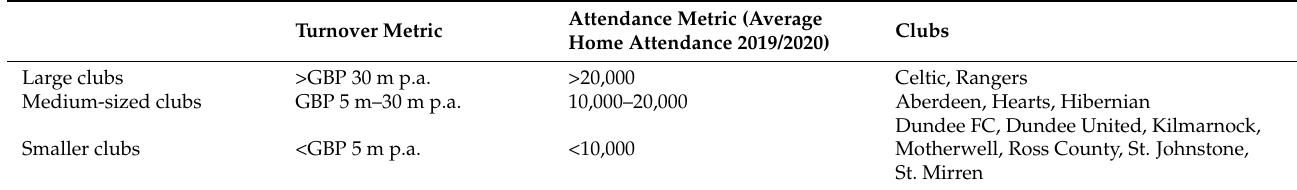
Table 1. SPFL Premiership club size classification.